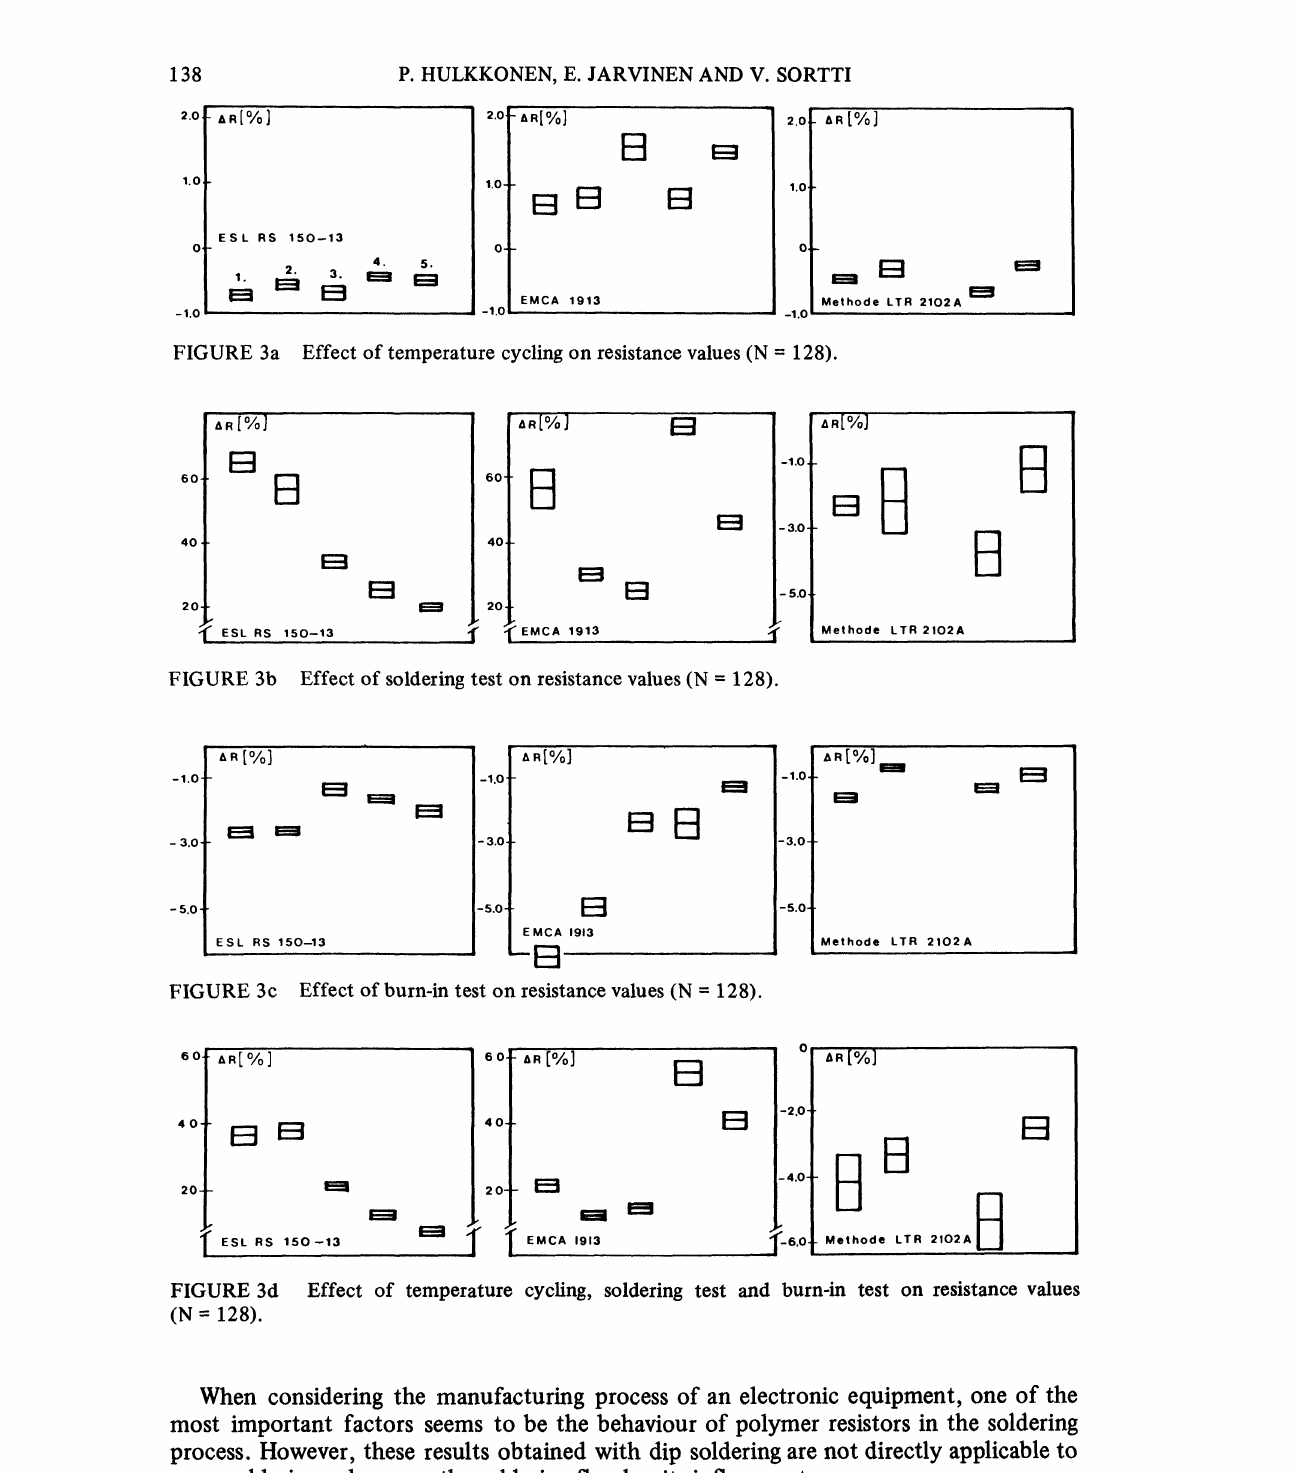
FIGURE 3d Effect of temperature cycling, soldering test and burn-in test on resistance values (N